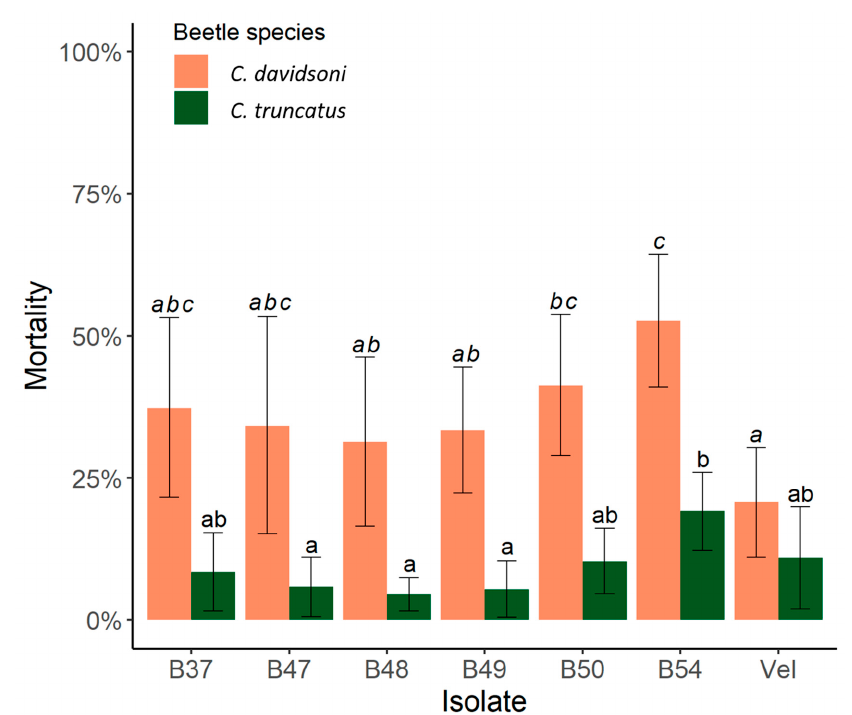
Figure 1. Cumulative Abbotts’s corrected mortality of adult Carpophilus spp. immersed in a suspension of B. bassiana conidia (10 7 conidia / mL) and incubated for 15 days. Di ff erent letters denote significant difference ( p < 0.05) performed on untransformed data with GLM analysis with post-hoc Tukey HSD test within beetle species. Error bars represent 95% confidence intervals.